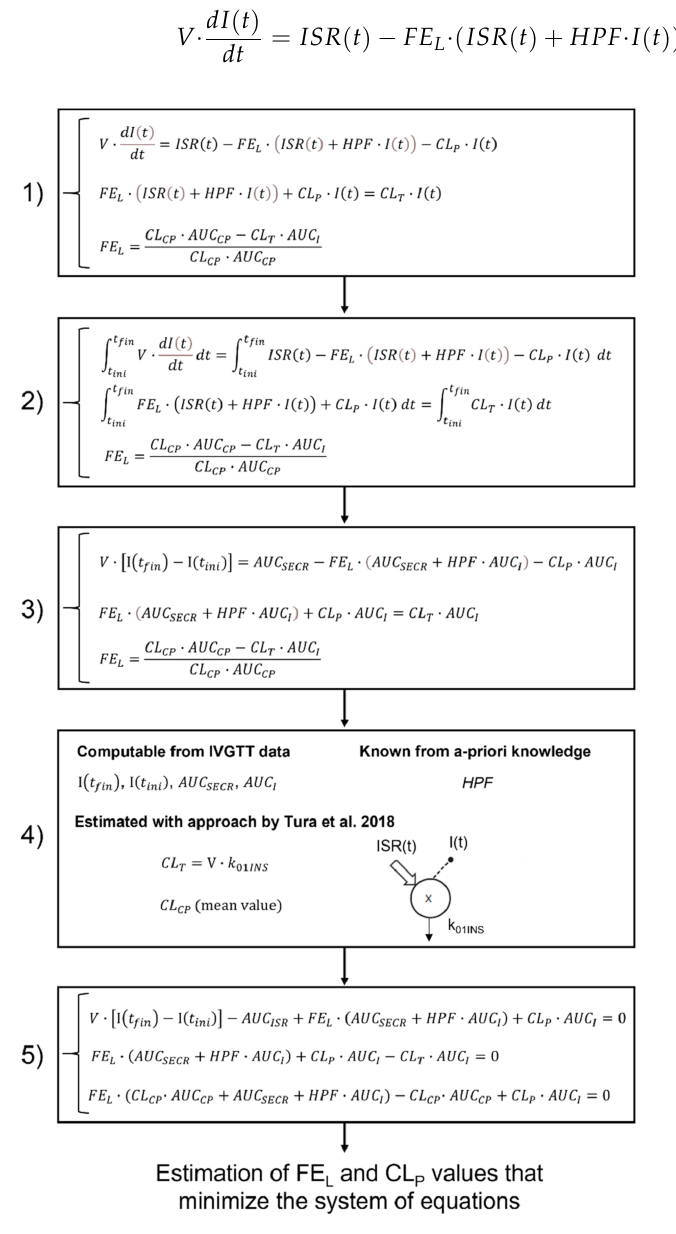
Figure 1. Flowchart of the methodology used to assess hepatic and extrahepatic insulin clearance. V: distribution volume; ISR(t): insulin secretion rate; FE L : hepatic insulin clearance; HPF(t): hepatic plasma flow rate; I(t): plasma insulin concentration; CL P : extrahepatic insulin clearance; CL T : total insulin clearance; CL CP : C-peptide clearance; AUC CP : area under the curve of C-peptide; AUC I : area under the curve of insulin; AUC SECR : area under the curve of ISR(t); t ini : initial time of IVGTT; t fin : final time of